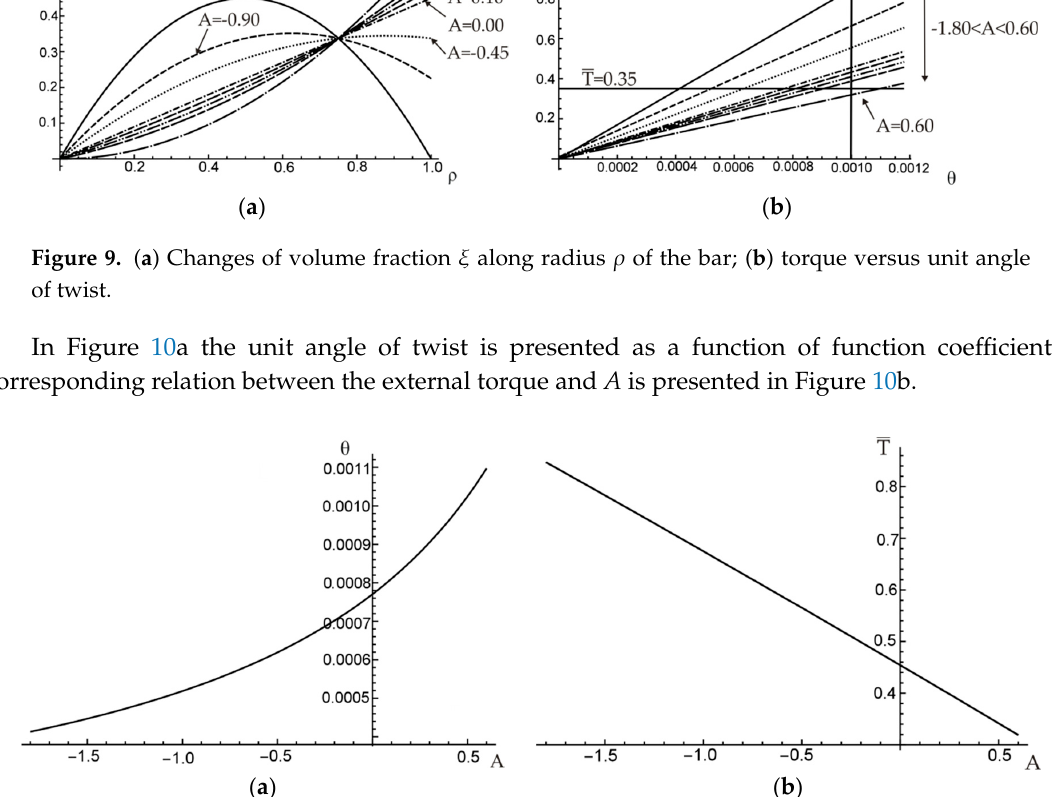
Figure 11. The distribution of shearing stress